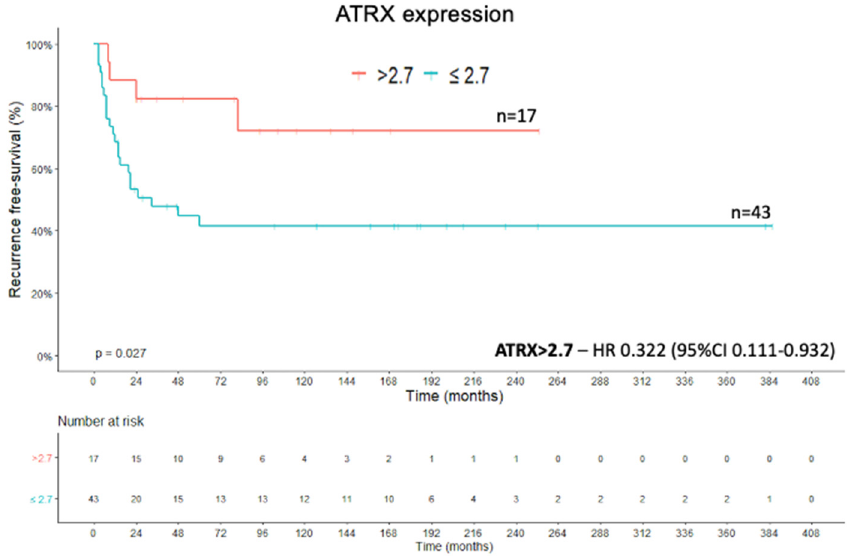
Figure 7. ATRX expression—Recurrence-free survival Kaplan–Meier curve.